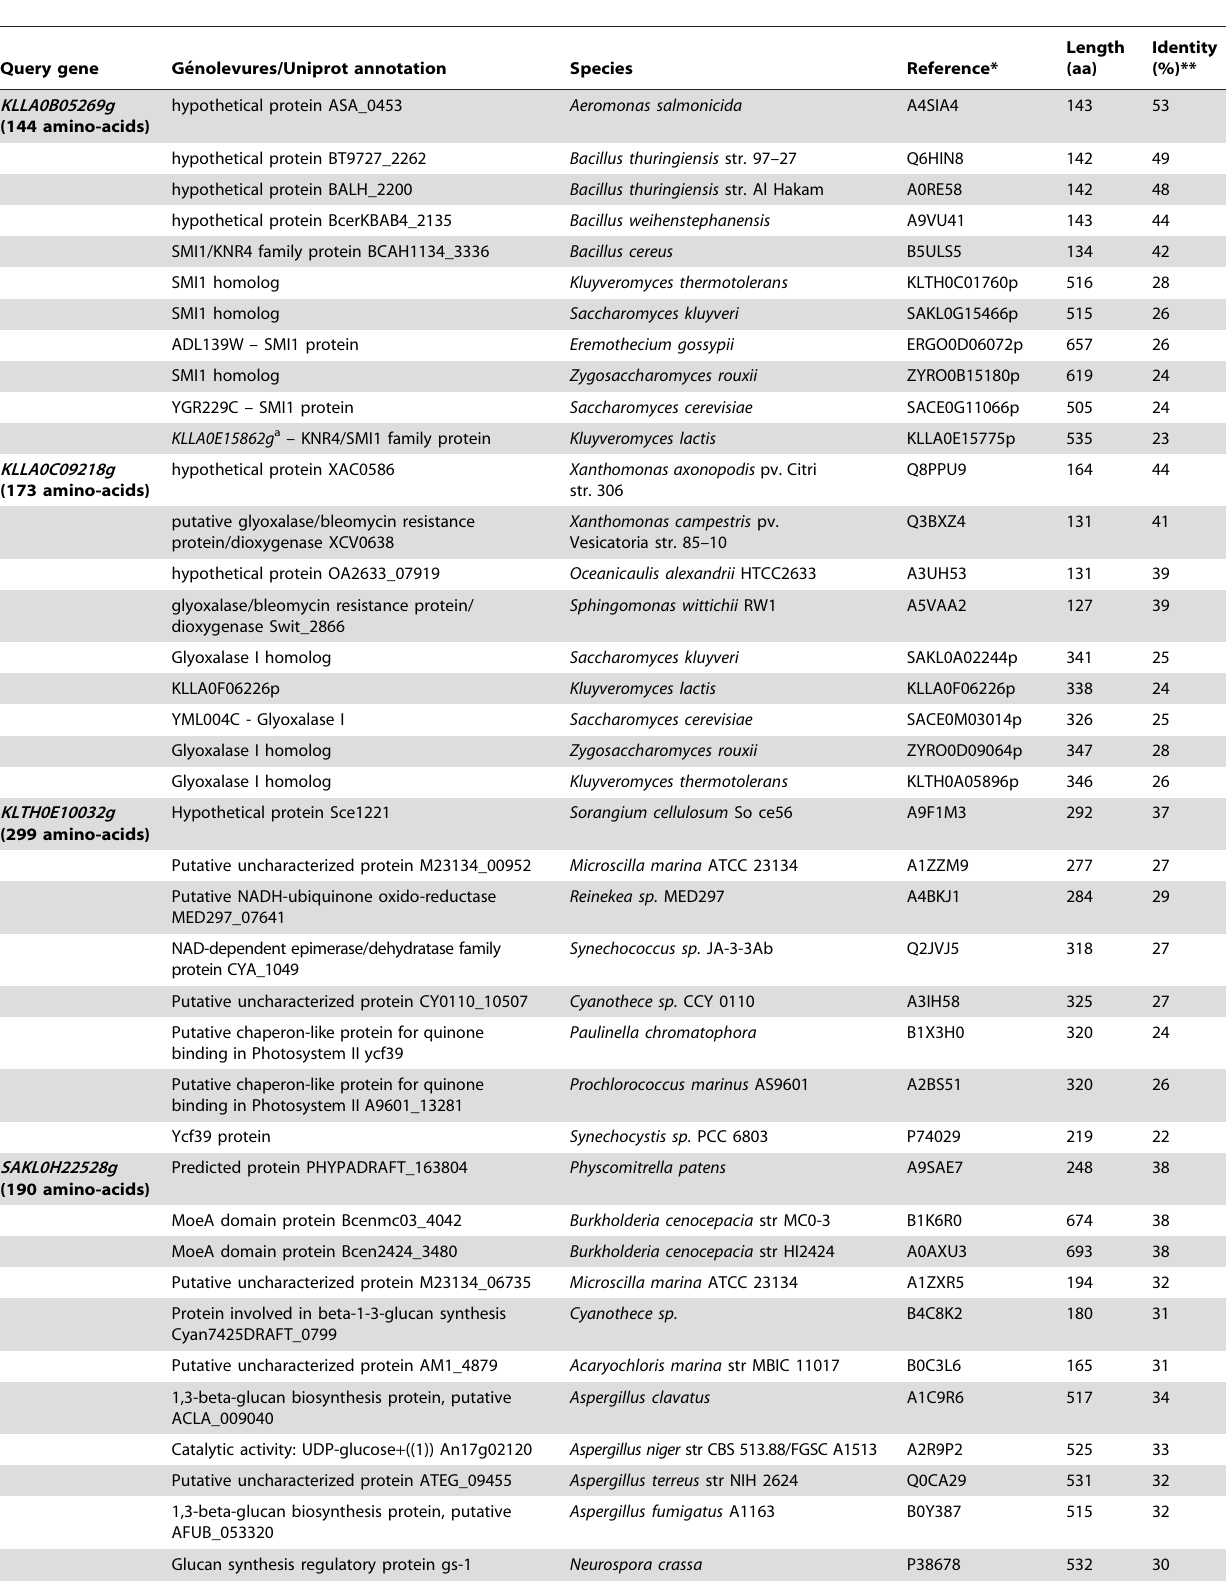
Table 1. Pairwise sequence identity between single HGT candidate products, best bacterial hits and yeast/fungal similarly annotated